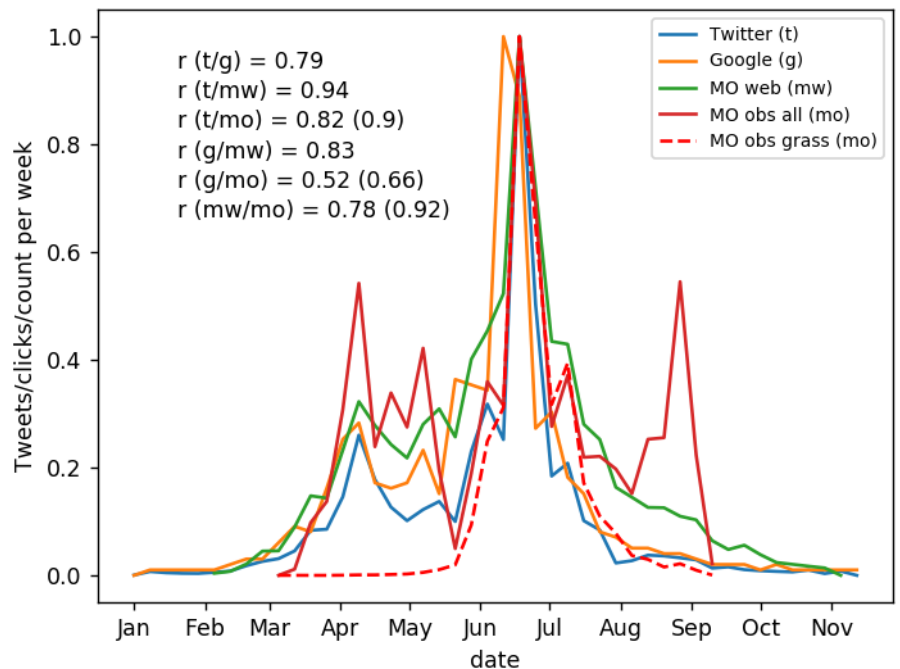
Figure 2. Time-series of various data sources for monitoring pollen and hayfever, aggregated weekly and normalised by their maximum value over the time period. Plot shows: Normalised Twitter activity ( t , blue), Google Trends web search activity ( g , orange), Met Office web traffic ( mw , green), counts for all pollen ( mo , solid red) and grass pollen ( mo , dashed red). Correlations, r, are given for each data source pair; pollen count correlations are for all pollen, with correlations for grass pollen only given in